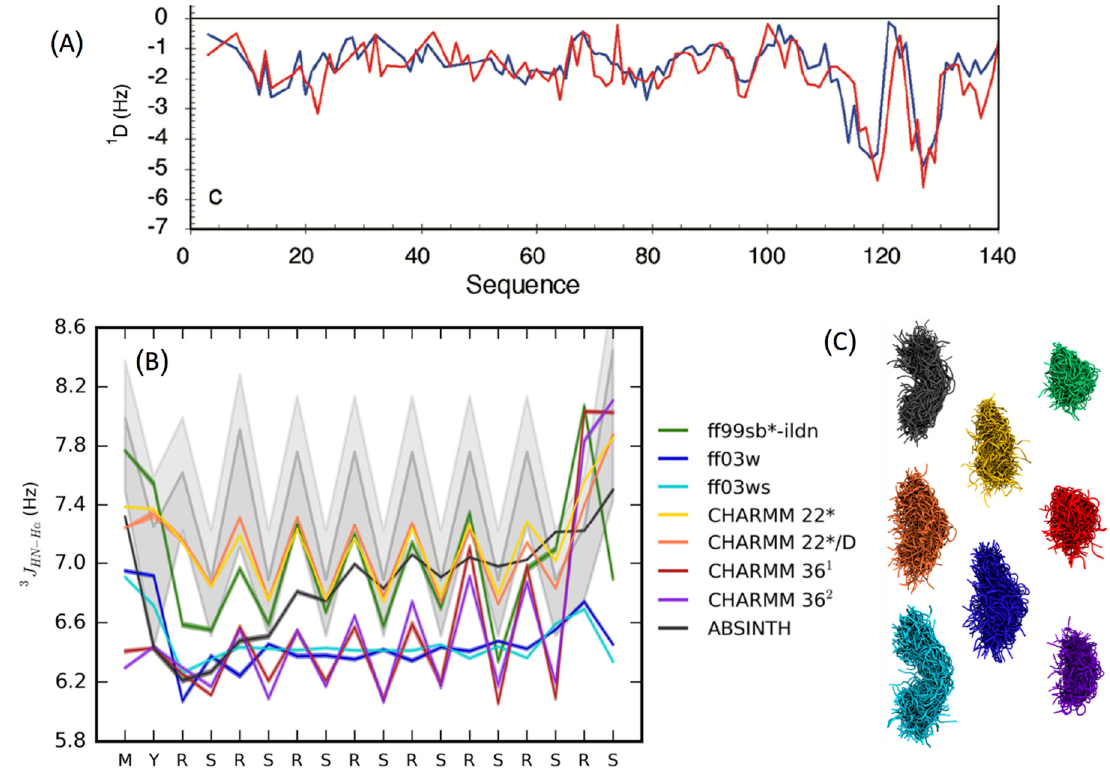
Figure 2. ( A ) Comparison between experimental (blue) and simulated 1 D NH residual dipolar coupling (RDCs, red) from ensemble of α -synuclein generated by flexible-meccano and ASTEROIDS (a selection tool for ensemble representations of intrinsically disordered states); reproduced with permission from [95]; ( B ) comparison of experimental J coupling data from a disordered peptide with those calculated from ensembles obtained from replica exchange molecular dynamics (REMD) simulations with various force fields; The experimental 3 J HN-H α couplings are shown in gray shading ( C ) ensembles obtained from various force fields in cartoon representation; reproduced with permission from [69].